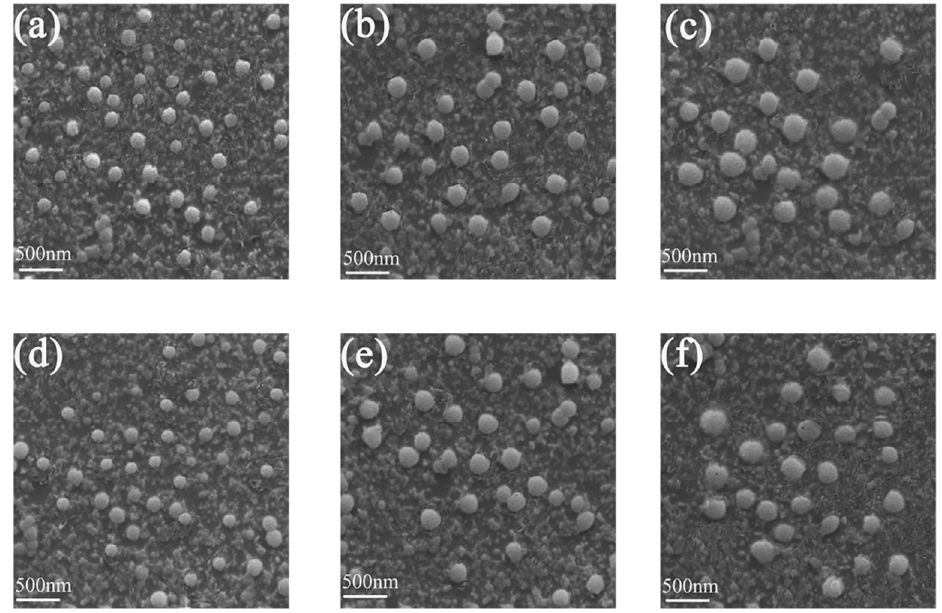
Figure 3. SEM images in the mixed solutions of CH 3 OH / H 2 O (5:5 v : v ) ( a ) 1 , ( d ) 2 . SEM images in the mixed solutions of CH 3 OH / H 2 O (2:8 v : v ) ( b ) 1 , ( e ) 2 . SEM images in the mixed solutions of CH 3 OH / H 2 O (1:9 v : v ) ( c ) 1 , ( f ) 2 .